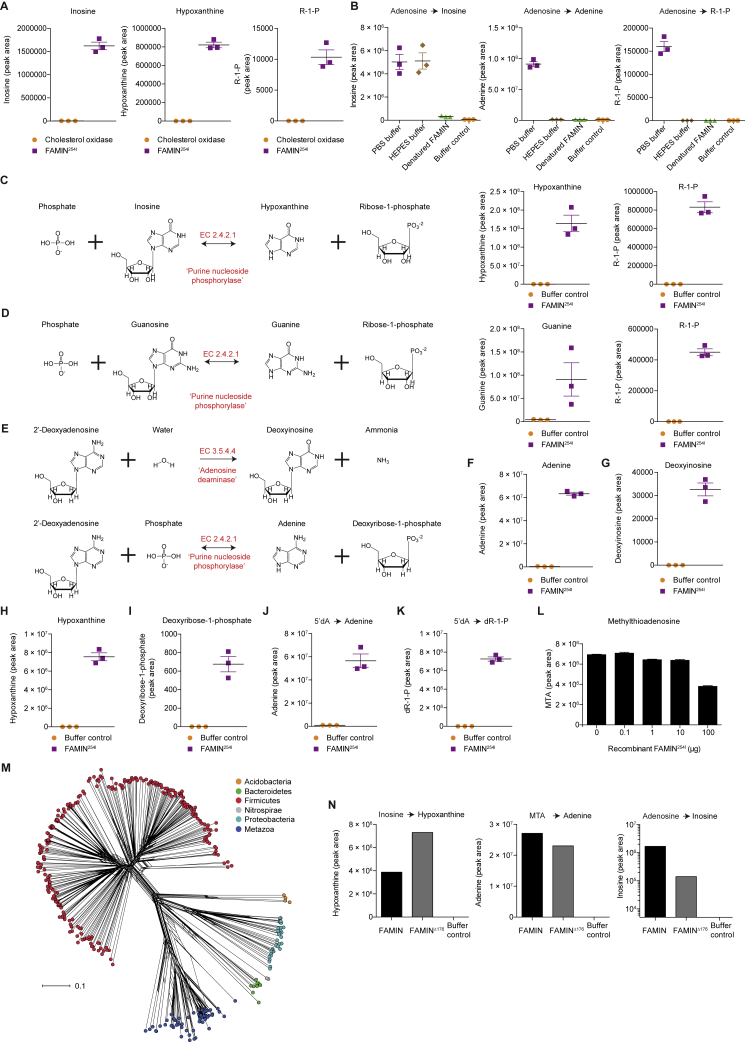
Characterization of FAMIN Enzymatic Activity, Related to Figure 2(A) Inosine, hypoxanthine and ribose-1-phosphate levels following incubation of 10 μg recombinant FAMIN254I or equimolar cholesterol oxidase with 10 μM adenosine for 1 h in 100 μL PBS (n = 3).(B) Adenine, inosine and ribose-1-phosphate levels following incubation of 10 μg recombinant Strep-tagged FAMIN254I or appropriate controls, including heat-denatured recombinant Strep-tagged FAMIN254I, with 10 μM adenosine for 1 h in 100 μL PBS or HEPES buffer (n = 3).(C and D) Left, FAMIN-catalyzed enzymatic reactions. Right, levels of guanine or hypoxanthine and ribose-1-phosphate in reactions containing 100 μM guanosine or inosine and recombinant FAMIN254I or buffer control in 100 μL after 1 h at 37°C (n = 3).(E–I) FAMIN-catalyzed enzymatic reaction with (F) adenine, (G) 2′-deoxyinosine, (H) hypoxanthine and (I) deoxyribose-1-phosphate levels following incubation of 10 μg recombinant Strep-tagged FAMIN254I or buffer control with 10 μM 2′deoxyadenosine for 1 h in 100 μL PBS (n = 3).(J and K) Adenine (J) and deoxyribose-1-phosphate (K) levels following incubation of 10 μg recombinant Strep-tagged FAMIN254I or buffer control with 10 μM 5′deoxyadenosine (5′dA) for 1 h in 100 μl PBS (n = 3).(L) MTA levels following incubation of 0.1, 1.0, 10.0 or 100.0 μg of recombinant FAMIN254I with the complete metabolomic library (aqueous phase of methanol:chloroform extract of FAMIN-silenced HepG2 cells) in 100 μl PBS (n = 3).(M) Phylogenetic tree of FAMIN orthologs using human FAMIN protein sequence as the search input.(N) EC 3.5.4.4 (Adenosine deaminase), EC 2.4.2.1 (purine nucleoside phosphorylase) and EC 2.4.2.28 (MTA phosphorylase) activities of E. coli expressed recombinant full-length FAMIN and FAMINΔ176 as measured by inosine, hypoxanthine and adenine production following incubation of protein with 10 μM adenosine, inosine and MTA, respectively, in PBS.Data are represented as mean ± SEM. ∗p < 0.05, ∗∗p < 0.01, ∗∗∗p < 0.001 (unpaired, two-tailed Student’s t test).